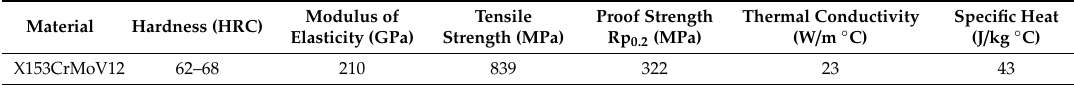
Table 2. Basic mechanical properties of the investigated 90MnCrV8